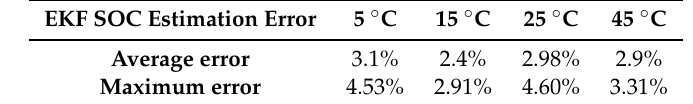
Table 11. EKF estimation error using the proposed OCV model at different temperatures.